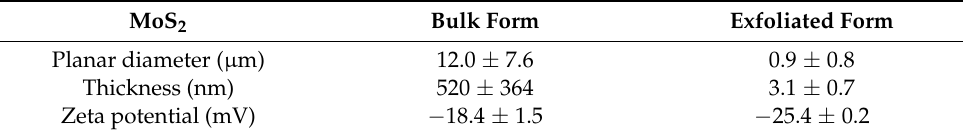
Figure 3. Normalized (with respect to initial concentration) survival of B. cereus in peptone water and MoS 2 suspension inoculated with ( a ) bulk MoS 2 and ( b ) exfoliated MoS 2 . The error bars represent the standard error of the mean. Similar to the studies with Gram ‐ positive B. cereus , the influence of MoS 2 on the sur ‐ vival of Gram ‐ negative P. aeruginosa was also investigated (Figure 4). At a concentration of 16.0 mg/mL, the log ‐ reduction in bacterial survival was ~1.9 (98.6%) and ~5.5 (99.9997%) for bulk MoS 2 and exfoliated MoS 2 , respectively. Overall, P. aeruginosa demonstrated a slightly higher survival rate than B. cereus against bulk MoS 2 , whereas exfoliated MoS 2 , above a concentration of 1.6 mg/mL, resulted in the lower survival of P. aeruginosa com ‐ pared to B. cereus .